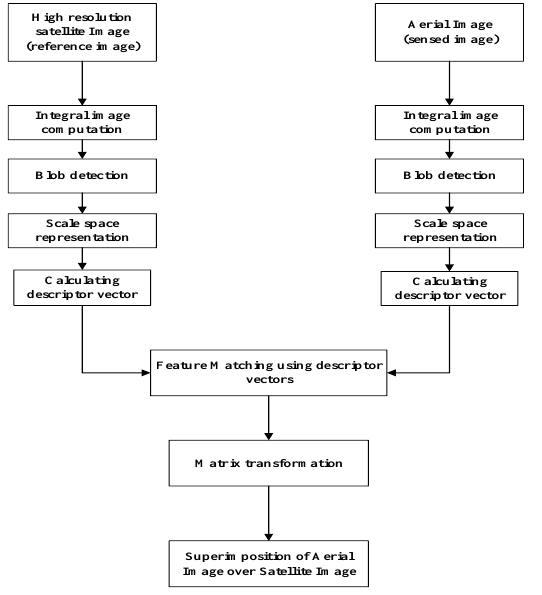
Figure 2. Image Registration sequence for Satellite and Aerial Images